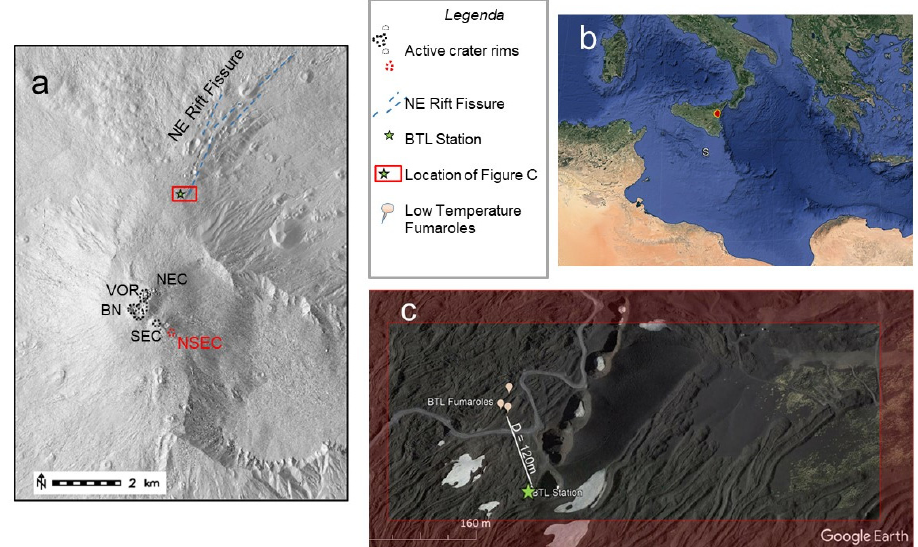
Figure 1. ( a ) Digital elevation model of Mt. Etna volcano showing the locations of the sites mentioned in the text and the main volcano—tectonic landforms (e.g., caldera border, craters, fracture lines). NEC, VOR, BN, and NSEC stand for North-East Crater, Voragine, Bocca Nuova, and New South-East Crater (modified from [23]); ( b ) Google Earth image of the southern Mediterranean region, with an indication of the Mt. Etna volcano (red area with a yellow contour); ( c ) Google Earth image of the monitored area, corresponding to the box outlined in the red frame in Figure a.